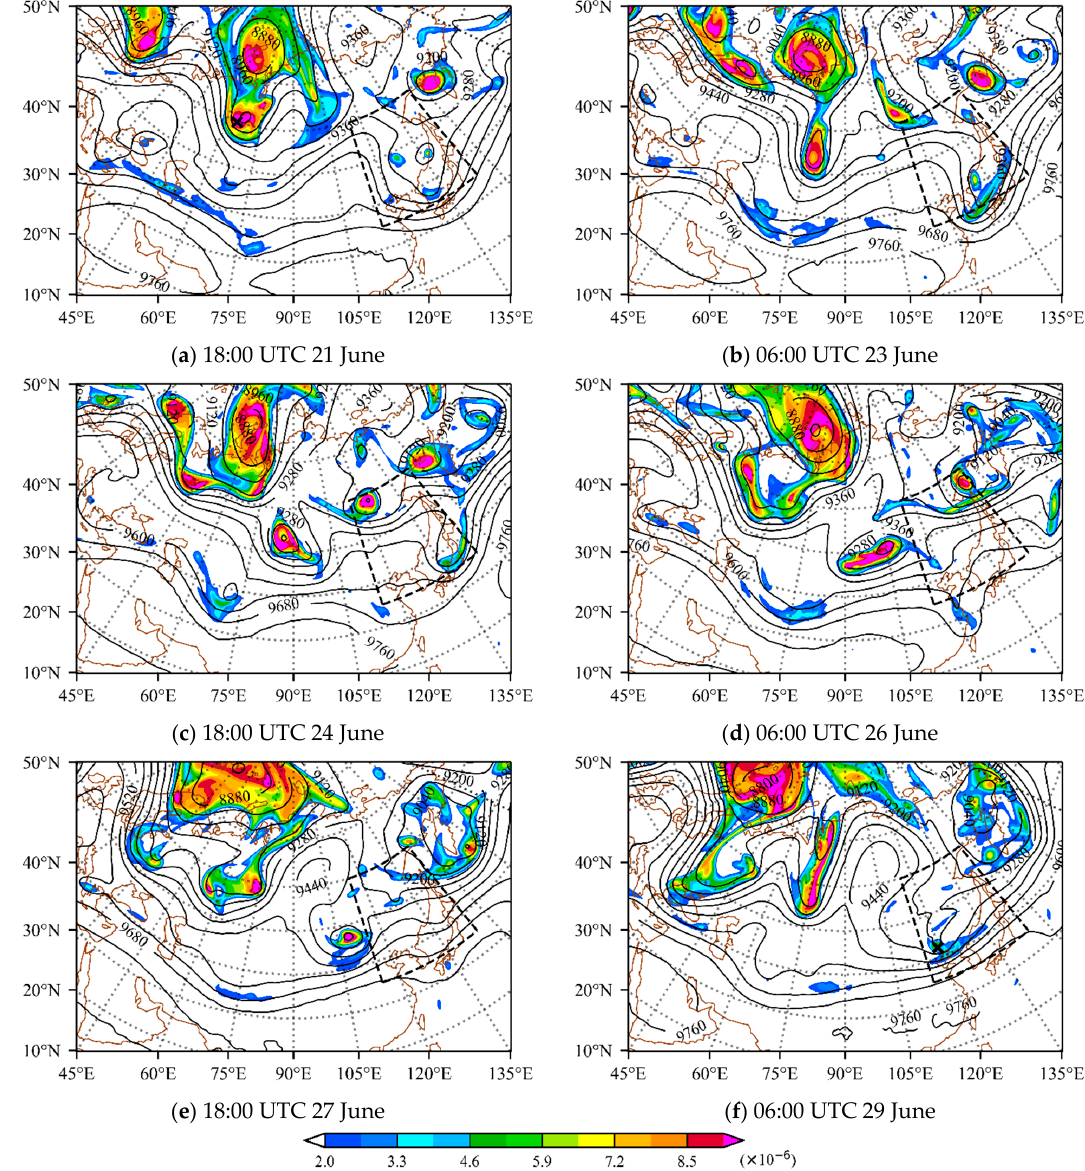
Figure 7. Spatial distributions of potential vorticity (color shaded, unit: K · m 2 · kg − 1 · s − 1 ) and geopotential height (contours, interval: 80 gpm) at 300 hPa of the ERA5 reanalysis from 21 to 29 June 2019. The black crosses in ( a , f ) indicate the NCCV centers determined by high PV center at 300 hPa. To confirm a gradual decrease of the tropopause height above the cutoff low, the traditional thermal tropopause [37] is provided in Figure 8. The ERA5 temperature pro- files from 21 to 29 June are used to calculate the tropopause following the method pro- posed by Reichler et al. (2003) [45]. The 500 hPa geopotential height is shown with tropo- pause pressure for reference. The tropopause pressure varies from roughly 90 to 360 hPa, and the cutoff low at 500 hPa often appears under a low tropopause. As the system weak- ens, the tropopause height would elevate.